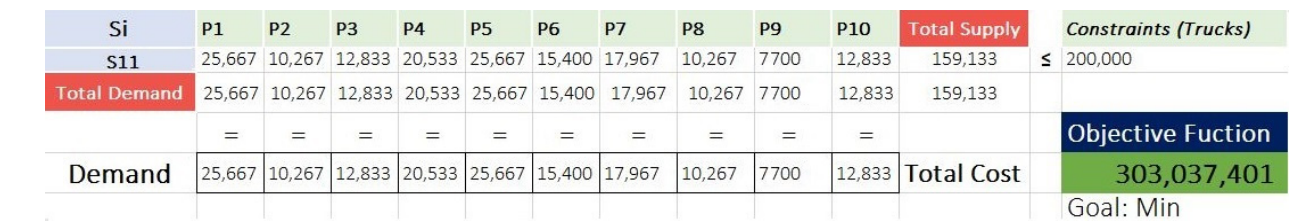
Figure 9. Scenario2 for SPL S 11 .